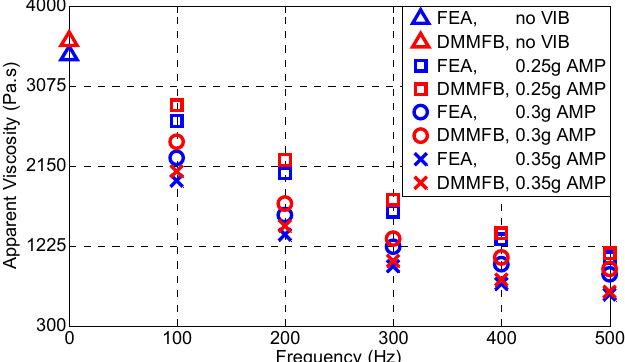
Figure 15. Effective value of the apparent viscosity without and with different-amplitude vibration